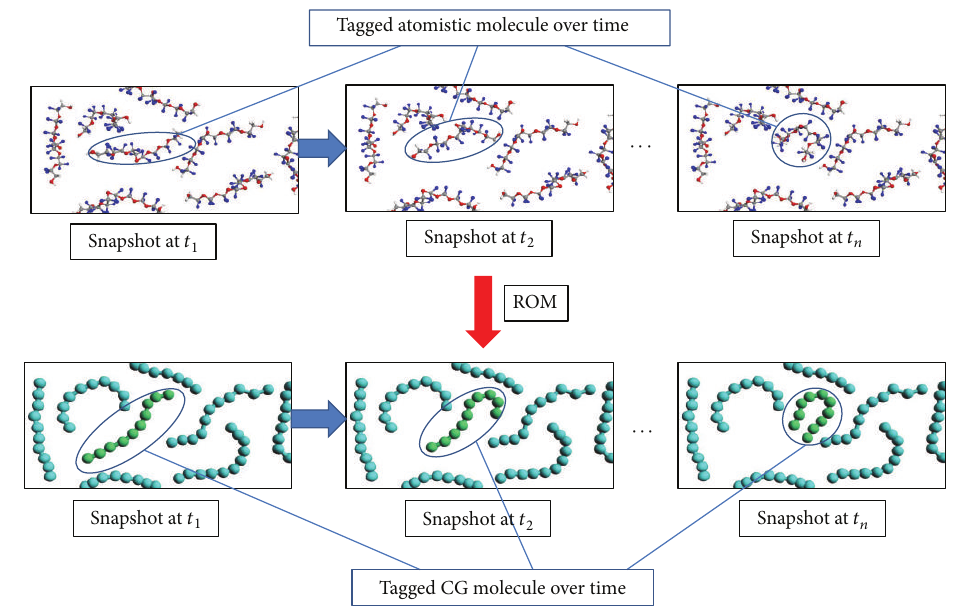
Figure 11: Illustration of coarse-graining procedure by using ROM for PFPE molecular systems.